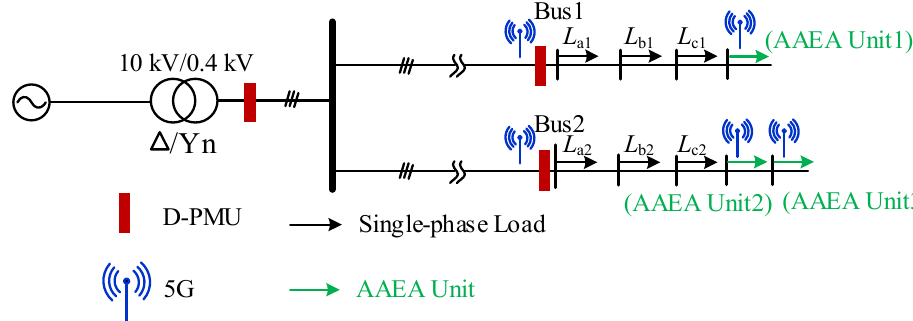
Figure 9. The single-line diagram of the tested LVDN with imbalanced single-phase loads.